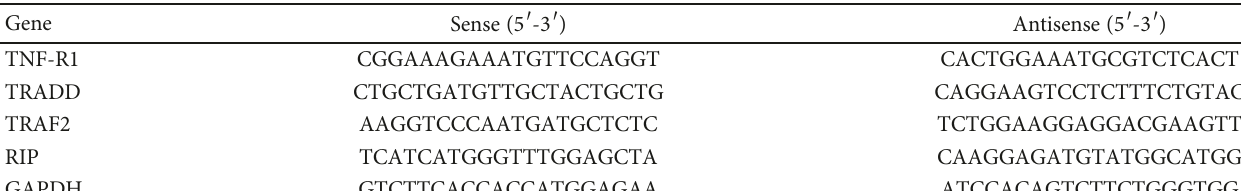
Table 1: The primers used in the real-time PCR.